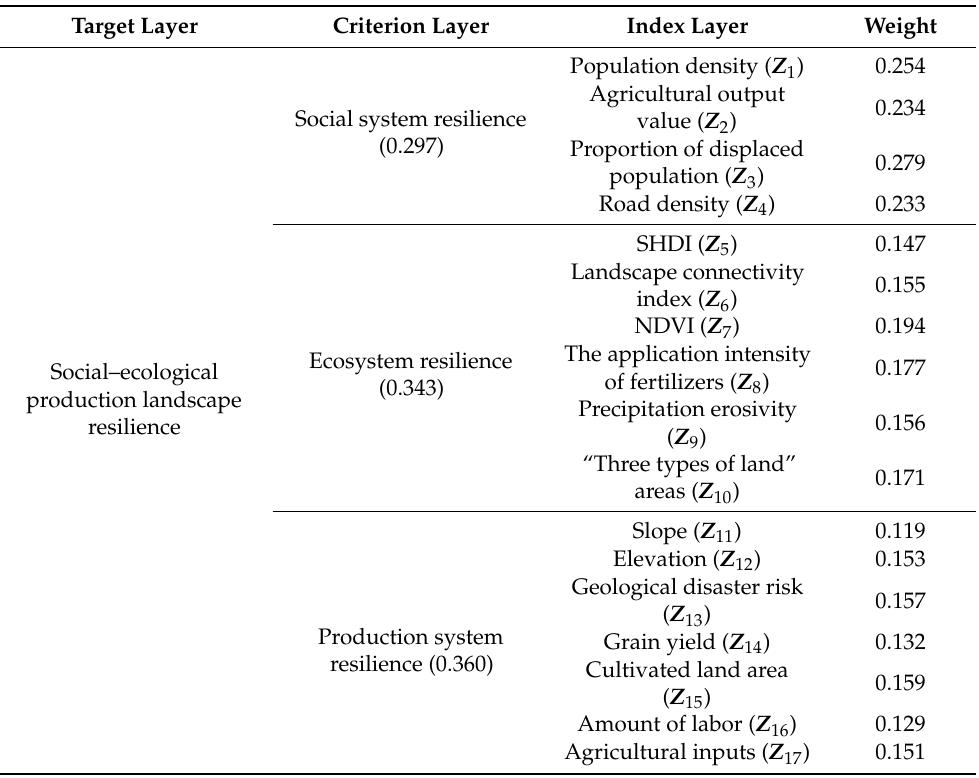
Table 2. Evaluation indicators of the social–ecological production landscape resilience (SEPLR) in the Loess Plateau